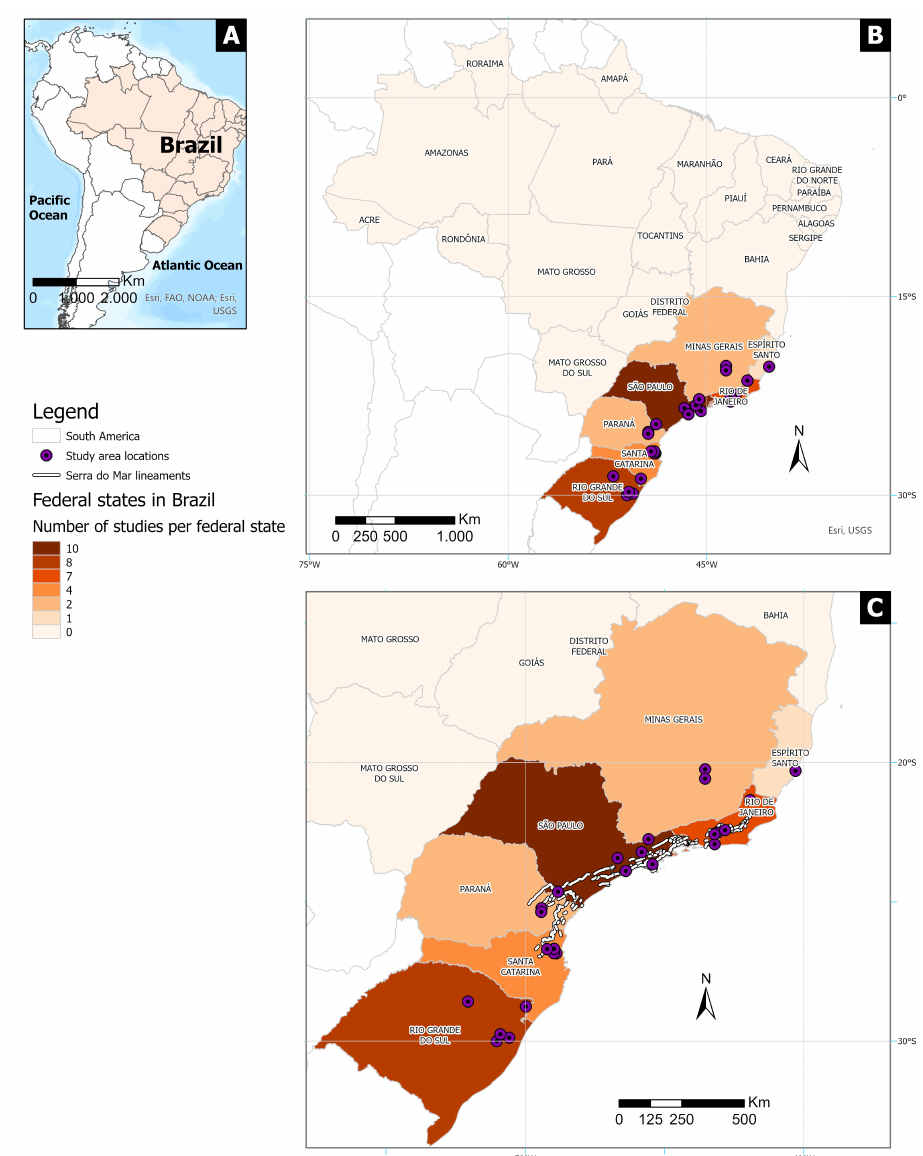
Figure 3. Location of the study areas in Brazil. ( A ) Overview map of South America; ( B ) locations (federal states) of the landslide susceptibility studies in Brazil. São Paulo is the state with the highest number of publications (10), followed by Rio Grande do Sul (8), and Rio de Janeiro (7); ( C ) location of Serra do Mar escarpments and study